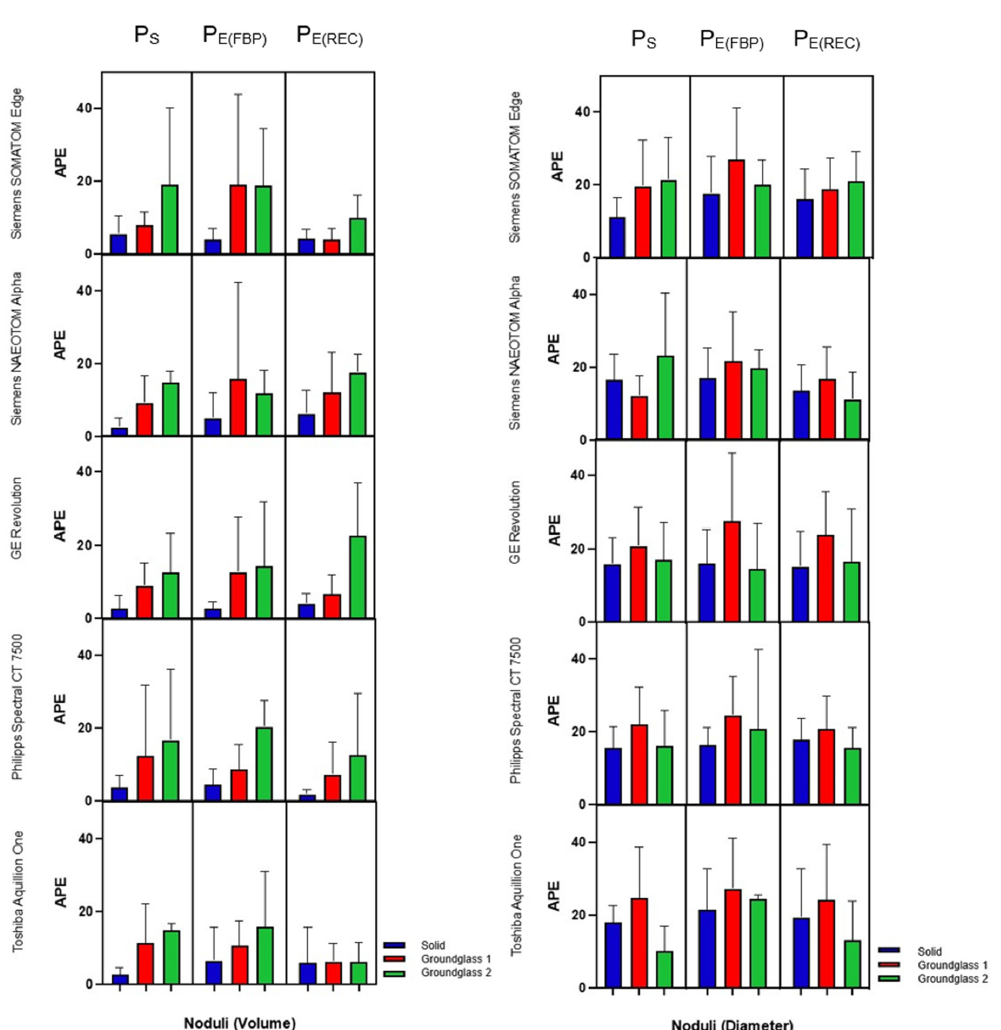
Figure 6. Box-plot diagram of absolute percentage errors (APEs) among different protocols and their respective computed tomography (CT) scanner. The colors indicate solid (blue), the ground-glass 1 (red) and ground-glass 2 (green) nodules. Measured nodule volumes are represented on the left and their corresponding diameters on the right. Institute-specific standard low-dose protocols (P S ) and ESTI protocols (P E ) reconstructed with filtered back projection (P E(FBP) ) as well as with iterative reconstruction (P E(REC) ) were